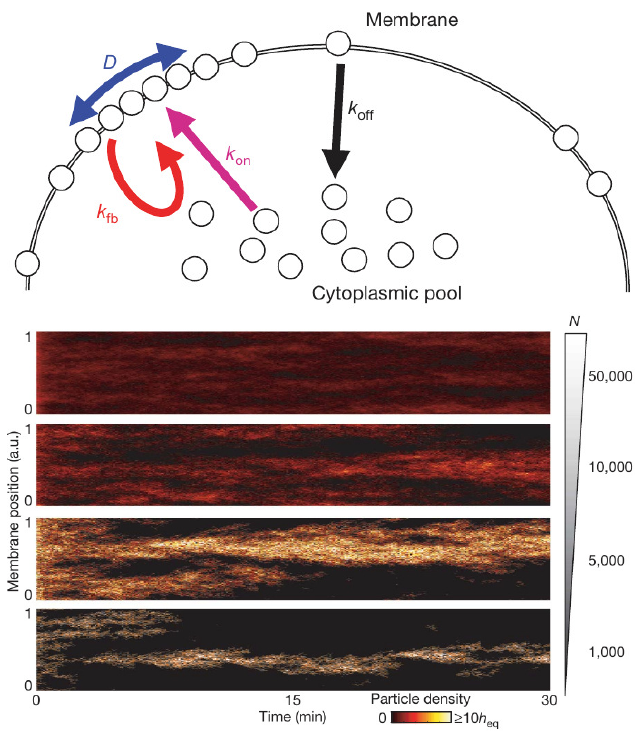
Figure 16. The reinforced-binding model. Modified from Altschuler et al. [122].